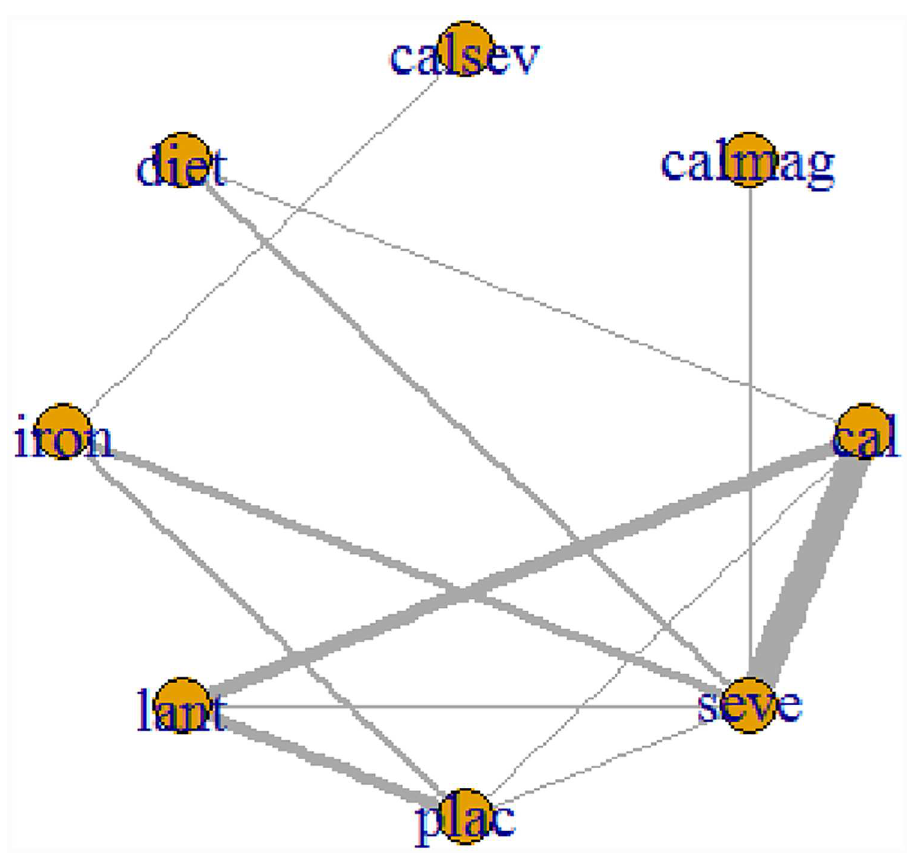
Fig 8. Network of clinical trials of phosphate binders in patients with chronic kidney disease: outcome mean change from baseline in serum parathyroid hormone concentration. Netplot of effectiveness outcome for mean parathyroidhormone reductionat the end of the study period. Network of randomized controlledtrials comparingdifferent phosphate binders for mean changein serum parathyroid hormone Lines connect different phosphate bindercategories with direct evidence.The width of lines correlatesthe number of RCTs for each direct comparisonwhilethe size of the nodescorrelates with the total sample size. Abbreviations: cal: calcium; calmag: calcium and magnesium;calsev: calcium and Sevelamer; Lant: lanthanum;seve: Sevelamer.